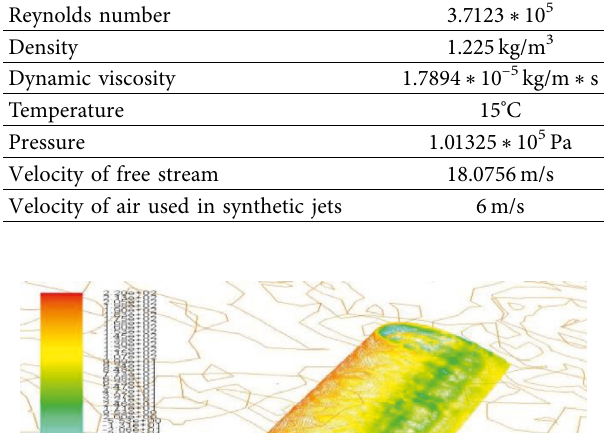
Table 2: Reference values used for analysis.